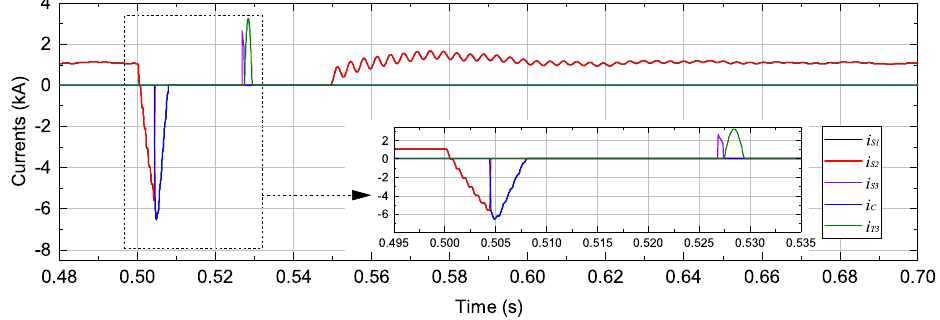
Figure 9. Overall currents on the switches of HCB 2.